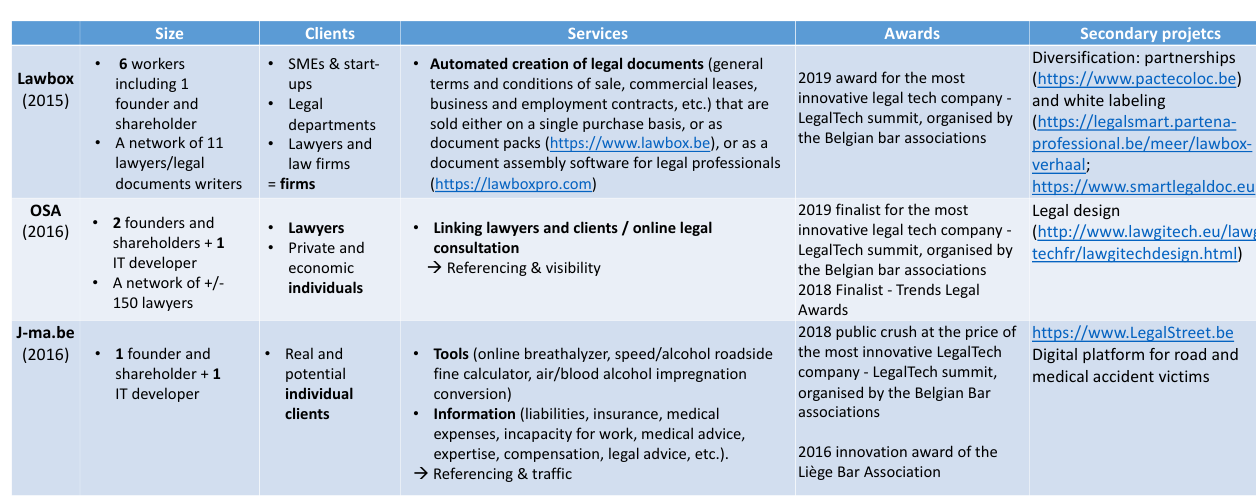
Table 1: Brief Description of the Three LegalTech Projects Under Study